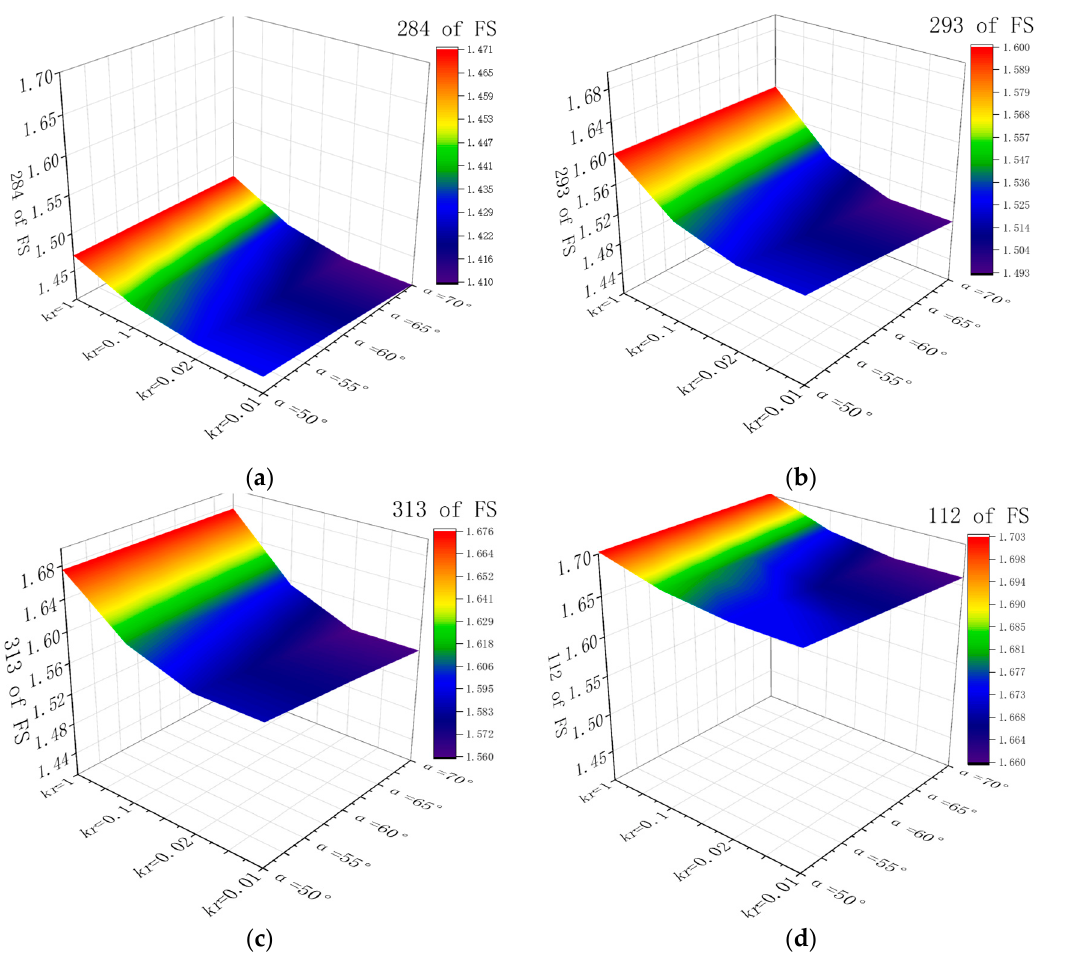
Figure 15. Variations in the safety factors of the different slip surfaces when rainfall ceased: ( a ) 284 slip surfaces; ( b ) 293 slip surfaces; ( c ) 313 slip surfaces; ( d ) 112 slip surfaces.